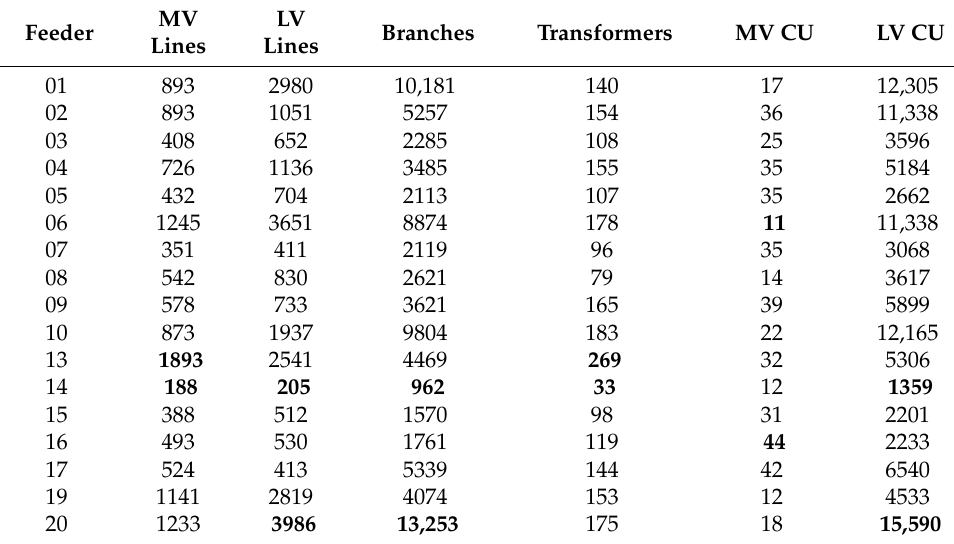
Table 4. Characteristics of the Goiania Leste substation